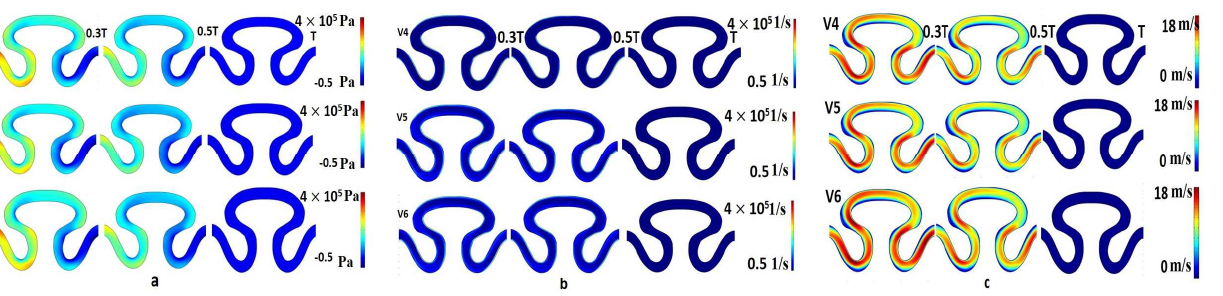
Figure 8. Contour Plot of ( a ) pressure, ( b ) shear rate, ( c ) axial velocity for physiological flow, no-slip wall boundary condition for velocity models V 4 , V 5 and V 6 . The contour plot of physiological flow with slip wall boundary condition (condition IV) depicts that for velocity model V 4 , the pressure magnitude at T/3 and T/2 sec was min- imum (0.2 × 10 10 Pa). The maximum pressure (1 × 10 10 Pa) was developed at approximately the periphery of the neck region and the rear region at the end of the T cycle, as shown in Figure 9a. At T/3 and T/2 secs, local maximum pressure was developed near the periphery of P 1, as shown in Figure 9a . The contour plot of the shear rate was found similar for all velocity models of the physiological flow condition. The minimum shear rate correspond- ing to V 4 , V 5 , and V 6 were obtained as 1 × 10 7 , 0.2 × 10 5 , and 0 × 10 5 , respectively. Similarly, the maximum shear rate for V 4 , V 5 , and V 6 were 8 × 10 7 , 1.8 × 10 5 , and 2.5 × 10 5 , respectively, as shown in Figure 9b. A maximum axial velocity of 200 mm/min was developed on all measured points at T sec, which was extremely high as compared to other conditions shown in Figure 9c. For velocity models V 5 and V 6, a maximum pressure of 2.5 × 10 5 Pa had been observed on the entire channel at T/3 and T/2 sec at the inlet region. For the same period, the local maximum velocity for model V 6 were found to be higher than that of V 5 in the neck as well as the periphery of rear region. For the results obtained in Figure 9d, it was observed that the stress decreases with an increase in velocity. Global values of stress for all velocities fluctuated between 2 and 25 × 10 −10 N/m 2 in the rear region of the serpen- tine channel.